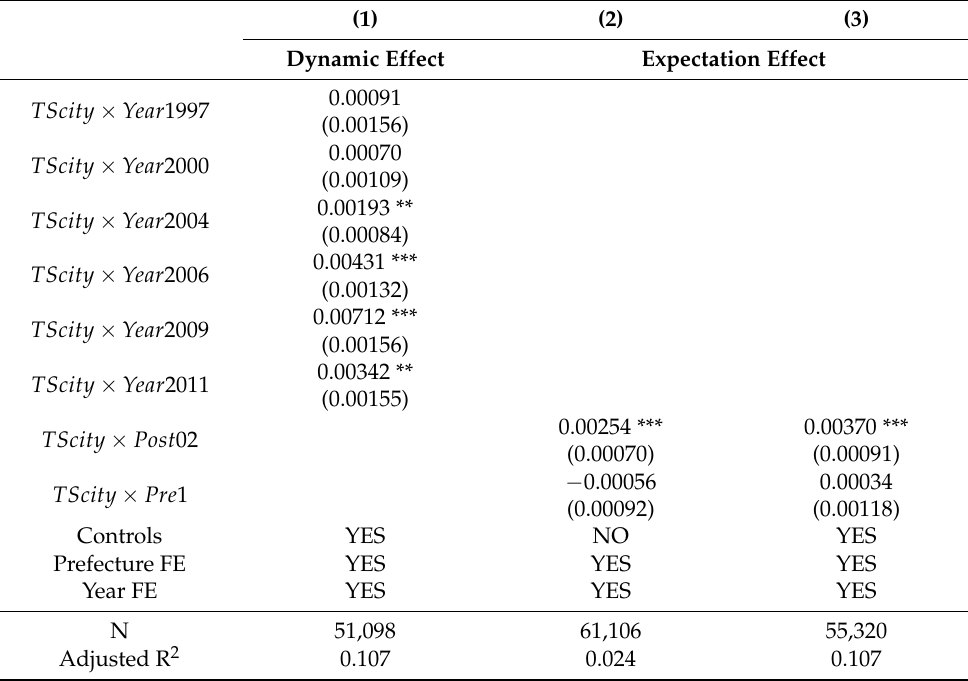
Table 3. Dynamic and expectation effect.